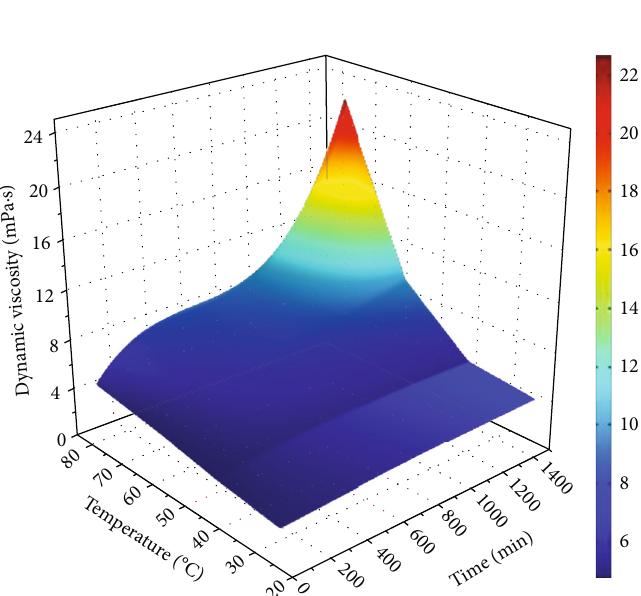
Figure 3: Viscosity-temperature-time relationships of